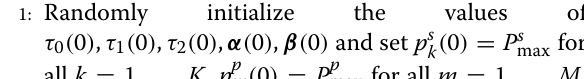
Algorithm 6 Data traffic offloading scheme with SIC decoder at the